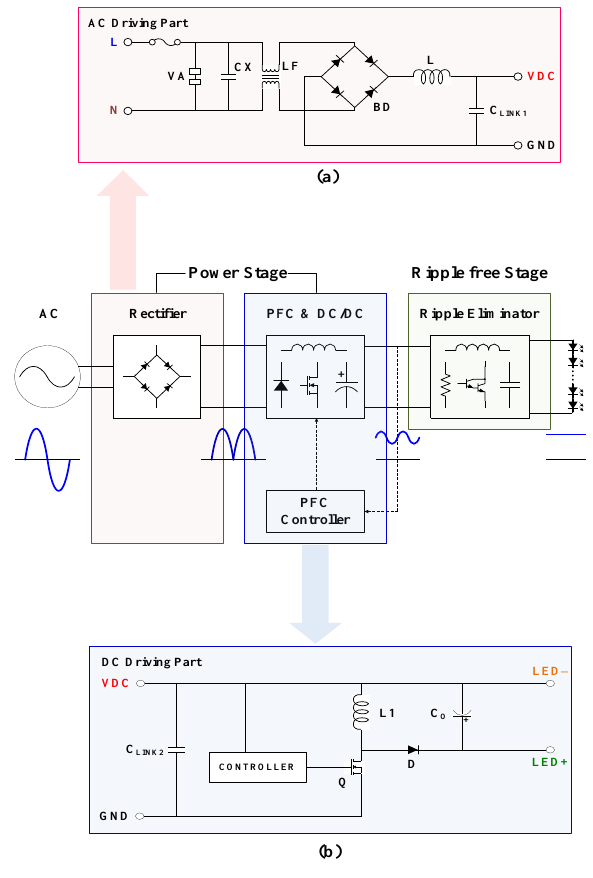
Figure 2. ( a ) Overall stages of the proposed LED converter; ( b ) simplified circuit diagram of AC and DC driving circuit.